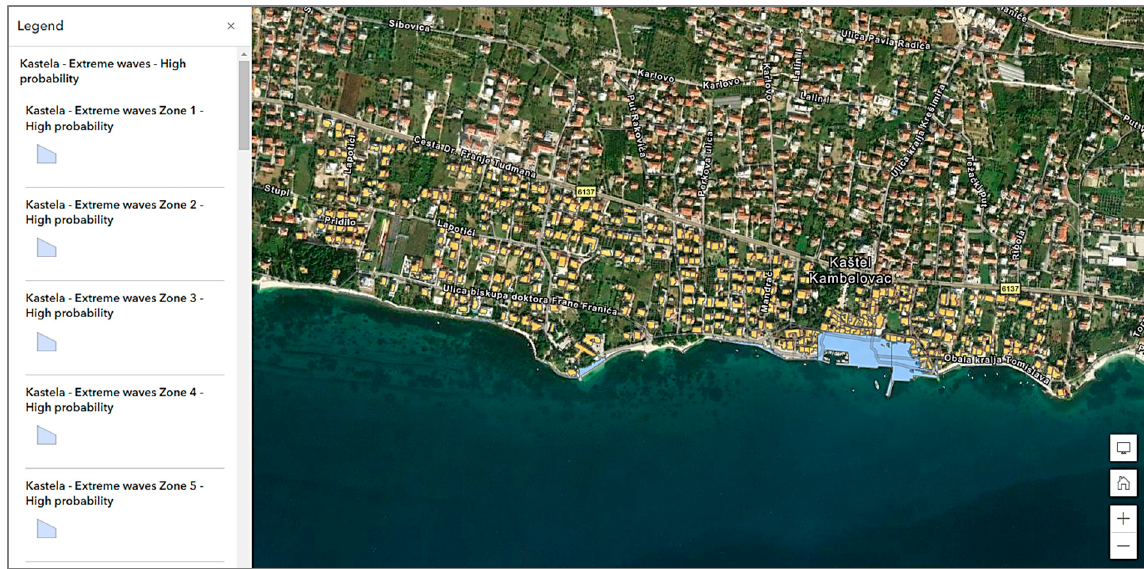
Figure 8. Distribution of critical zones most prone to extreme sea waves exposure.